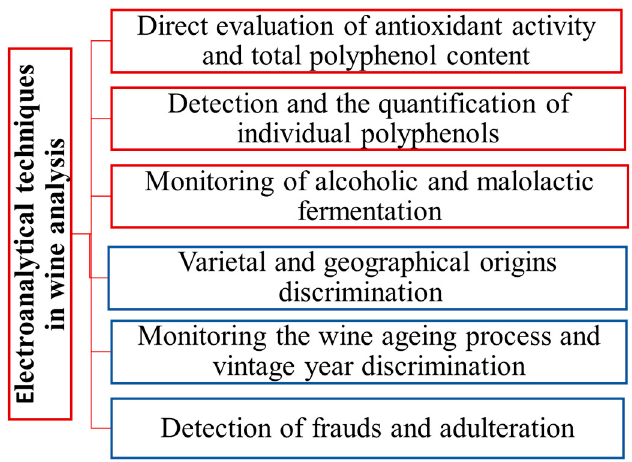
Figure 1. Principal application of electroanalytical techniques in wine analysis.